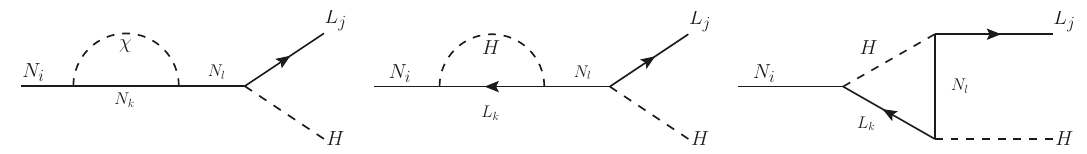
Figure 1 . The one-loop two-body decays of a RH neutrino N i to the SM fields (lepton and Higgs